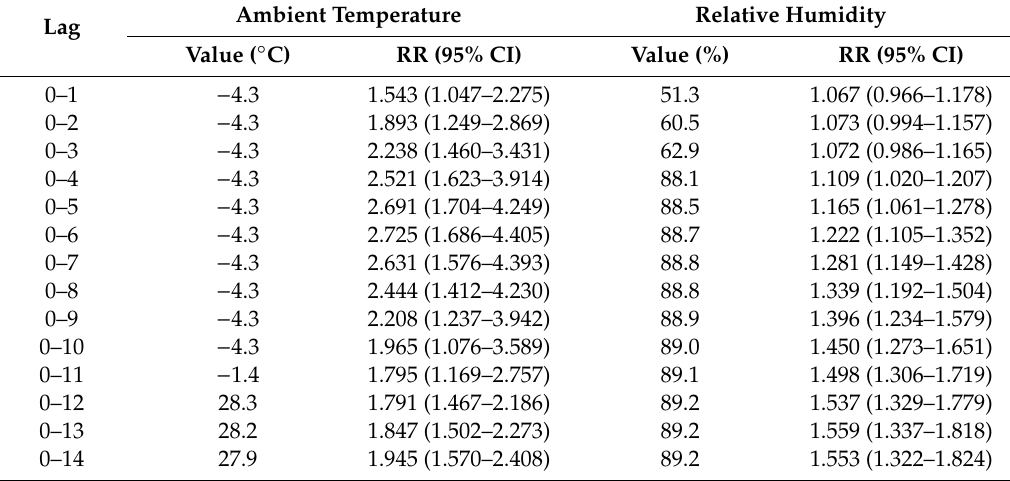
Table 4. The largest cumulative e ff ects of ambient temperature and relative humidity on the incidence of HFMD by lag period. Ambient Temperature Relative Lag